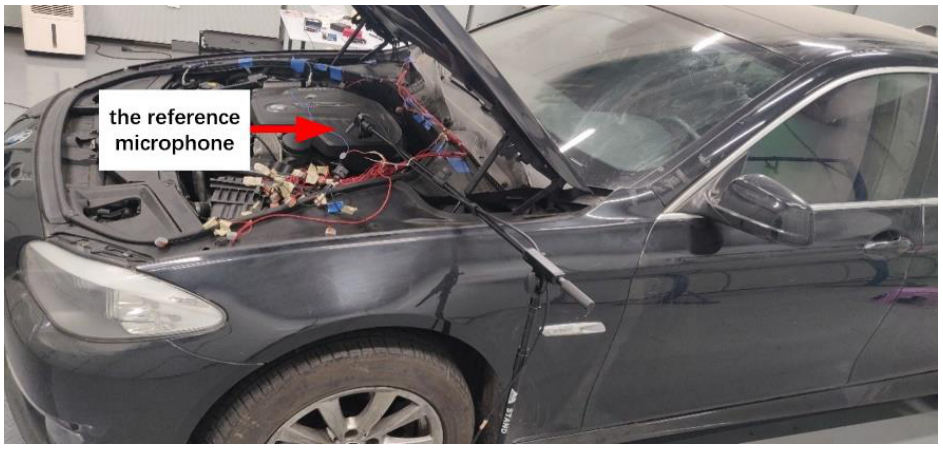
Figure 12. Arrangement of the reference sensor.